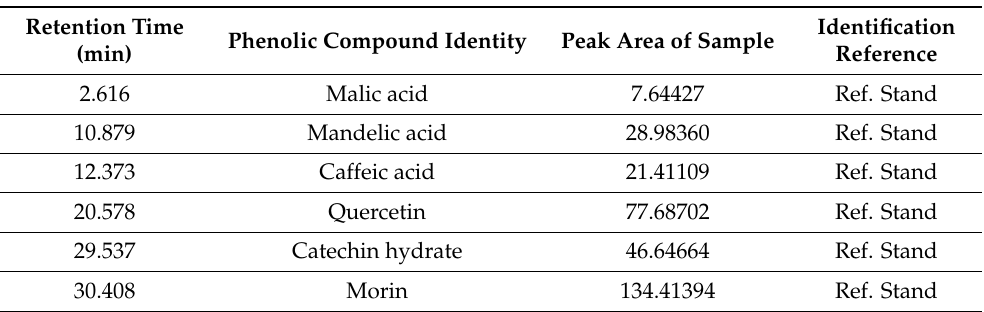
Table 2. Identification of bioactive compounds in Met + Ext of Cydonia oblonga through HPLC- UV technique.